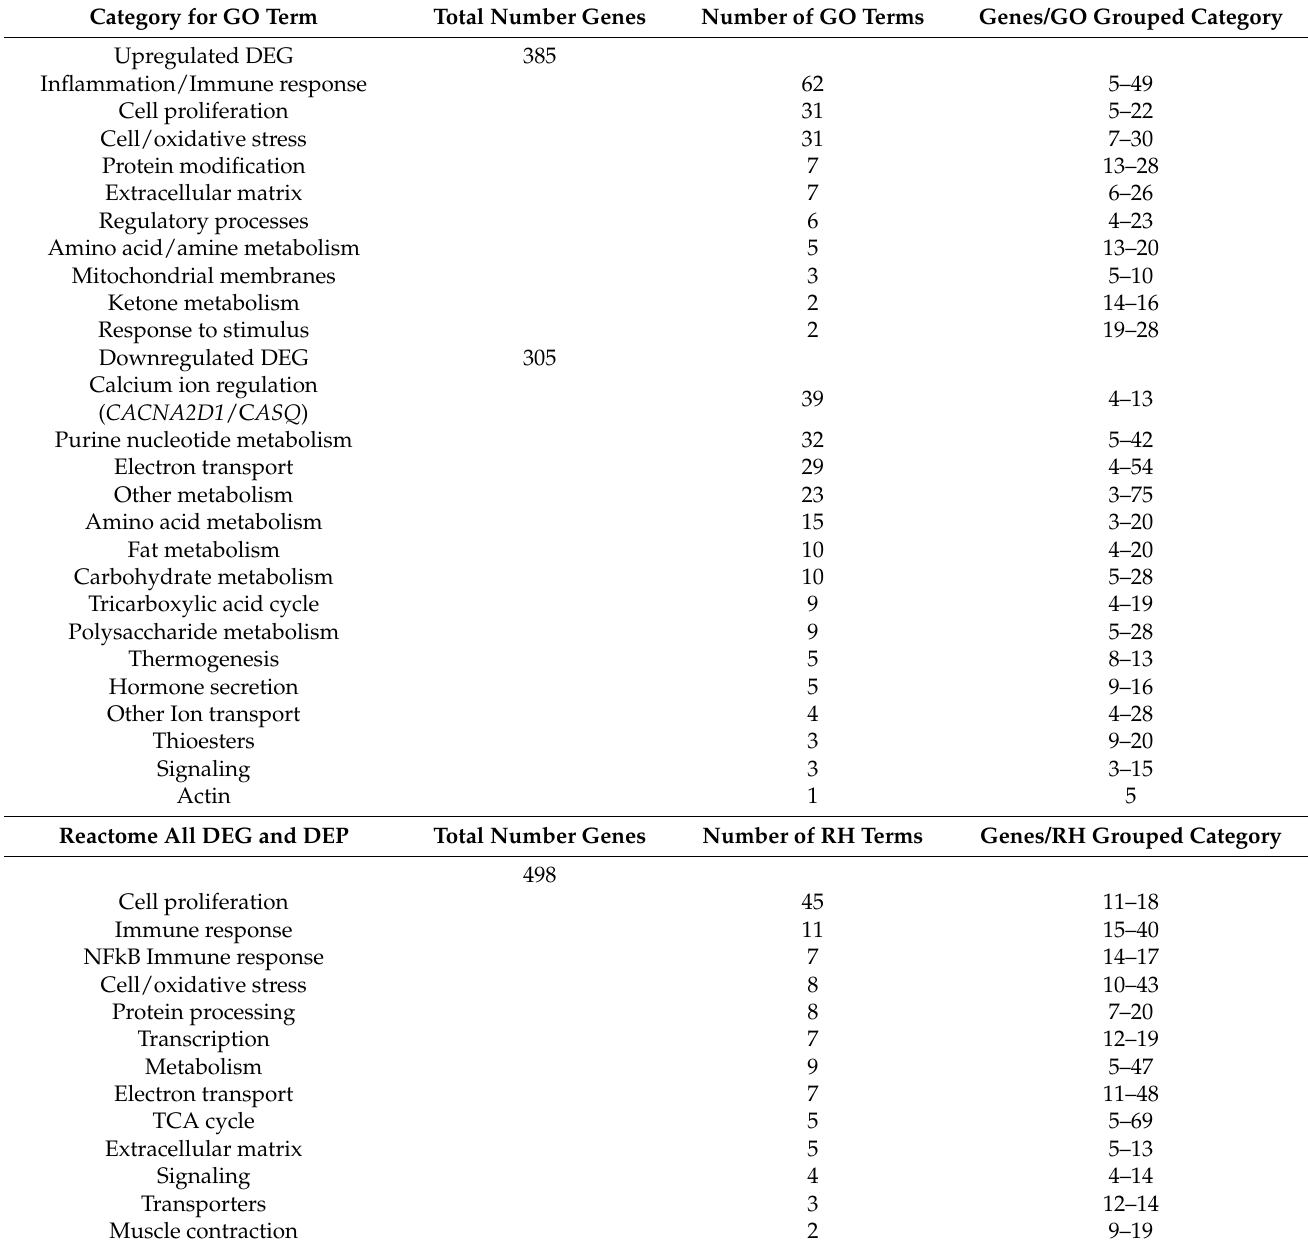
Table 2. Summary of categories for GO terms that were enriched for upregulated and downregulated genes (DEG) in biological processes and pathways in the Reactome (RH) for combined DEG and DEP. The number of GO terms in each category and the range in number of genes within the GO terms in each category are shown. The specific GO terms can be found in Table S4 and Reactome terms in Table